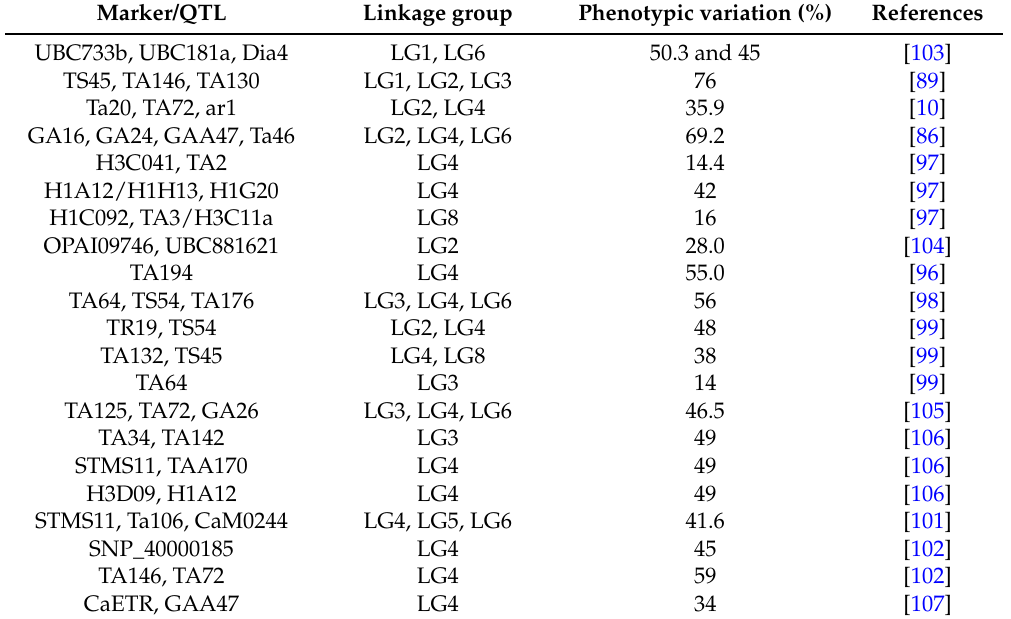
Table 3. The QTLs or genes identified for chickpea host resistance to Ascochyta